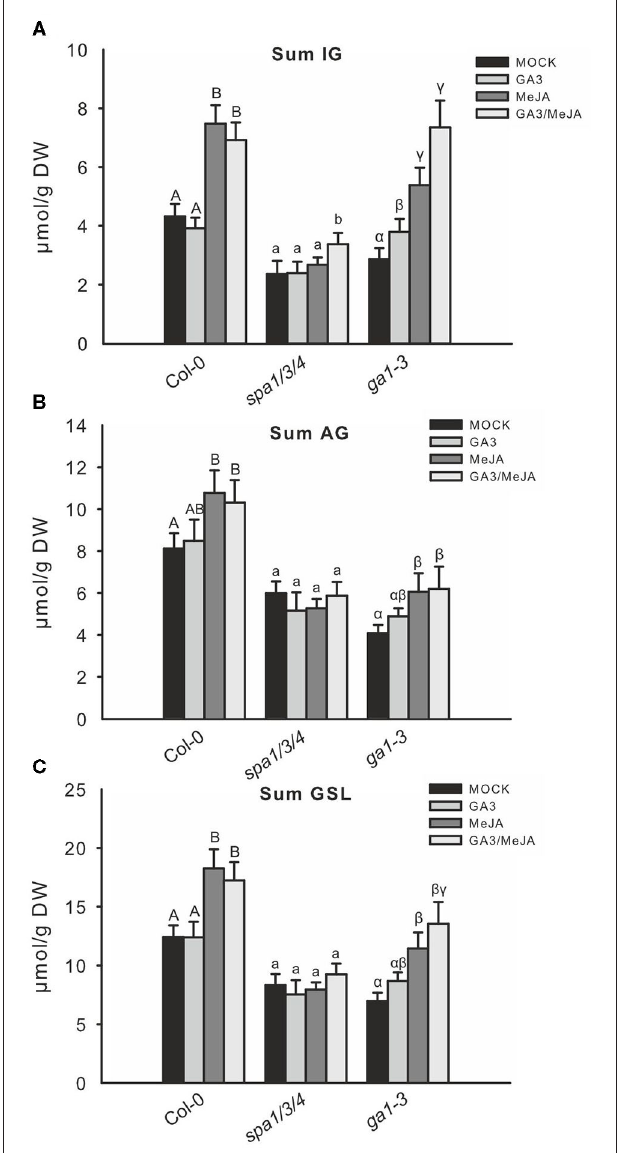
FIGURE 6 | Combined GA/JA treatment further increases the IG level in spa1/3/4 and ga1–3 mutants. The effect of combined GA/JA treatment on GSL accumulation was tested in 6-week- old spa1/3/4 , ga1–3 , and Col-0 wild-type plants sprayed with MOCK, 50 µ M GA 3 , 50 µ M MeJA, or 50 µ M MeJA/50 µ M GA 3 treatments. Data (A–C) are means ± SE from five independent experiments with four to six biological replicates in each case ( n = 25). Different letters indicate significant differences (the Kruskal—Wallis test followed by a Mann–Whitney pairwise test with Bonferroni-corrected p -values, p < 0.05).